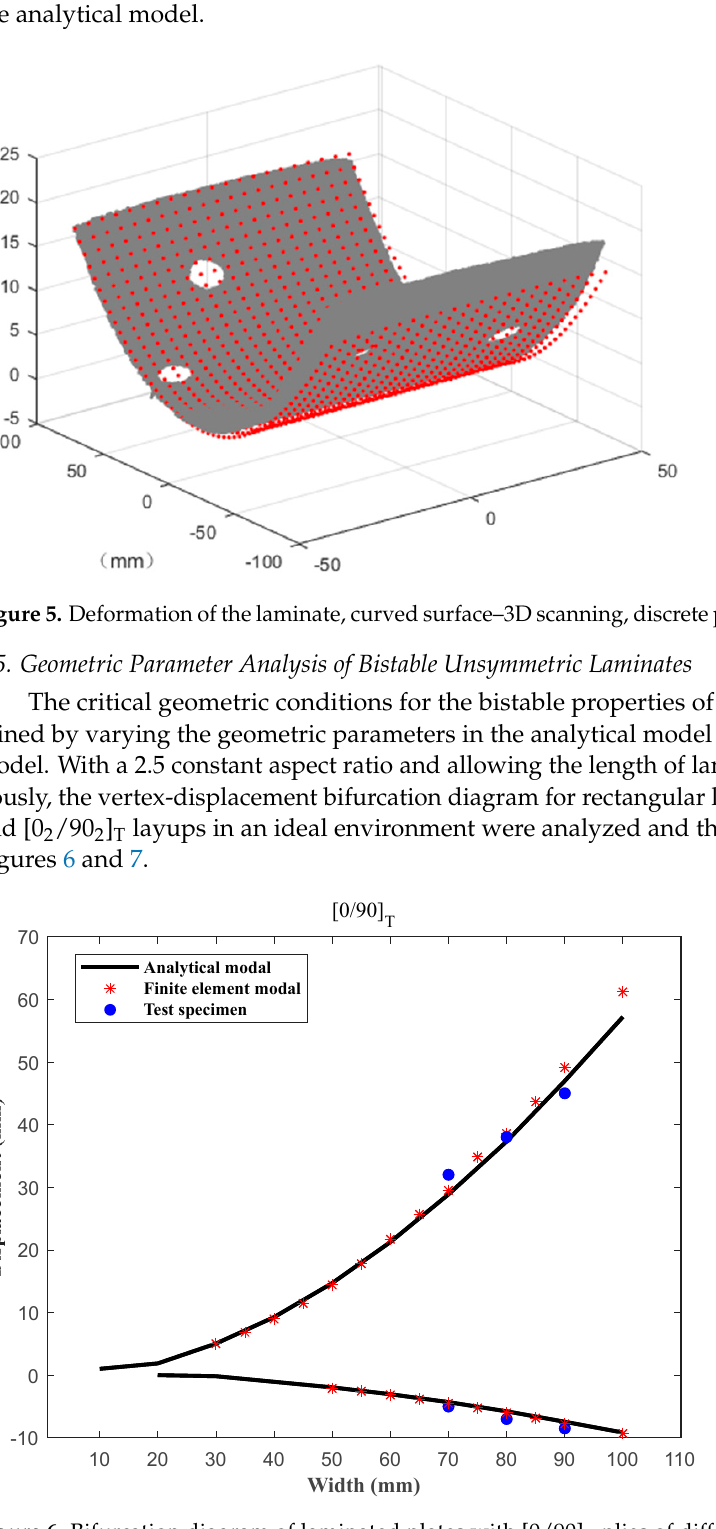
Figure 5. Deformation of the laminate, curved surface–3D scanning, discrete points–Analytical modal.